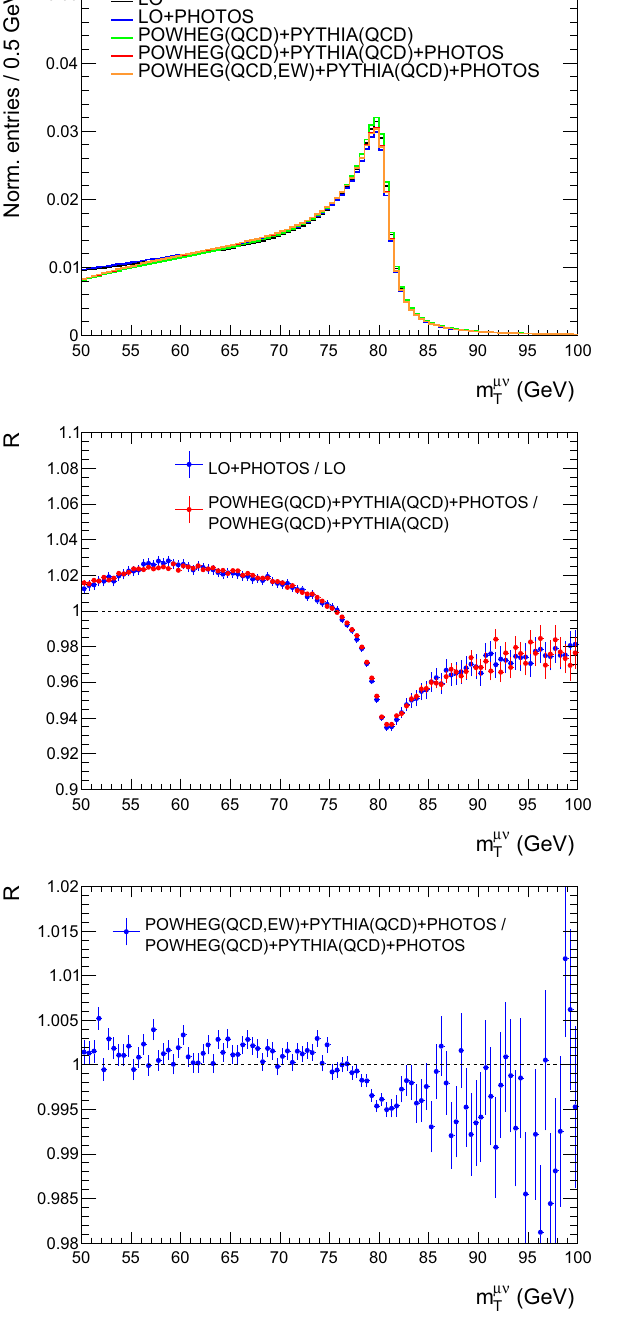
the corresponding quantities where the QED shower has been switched off is shown in the middle plots . The ratio of distributions including full NLO-(QCD+EW) corrections matched with (QCD+QED)-PS and thecorrespondingquantitieswhereonlyNLO-QCD+(QCD+QED)-PS has been retained is shown in the lower